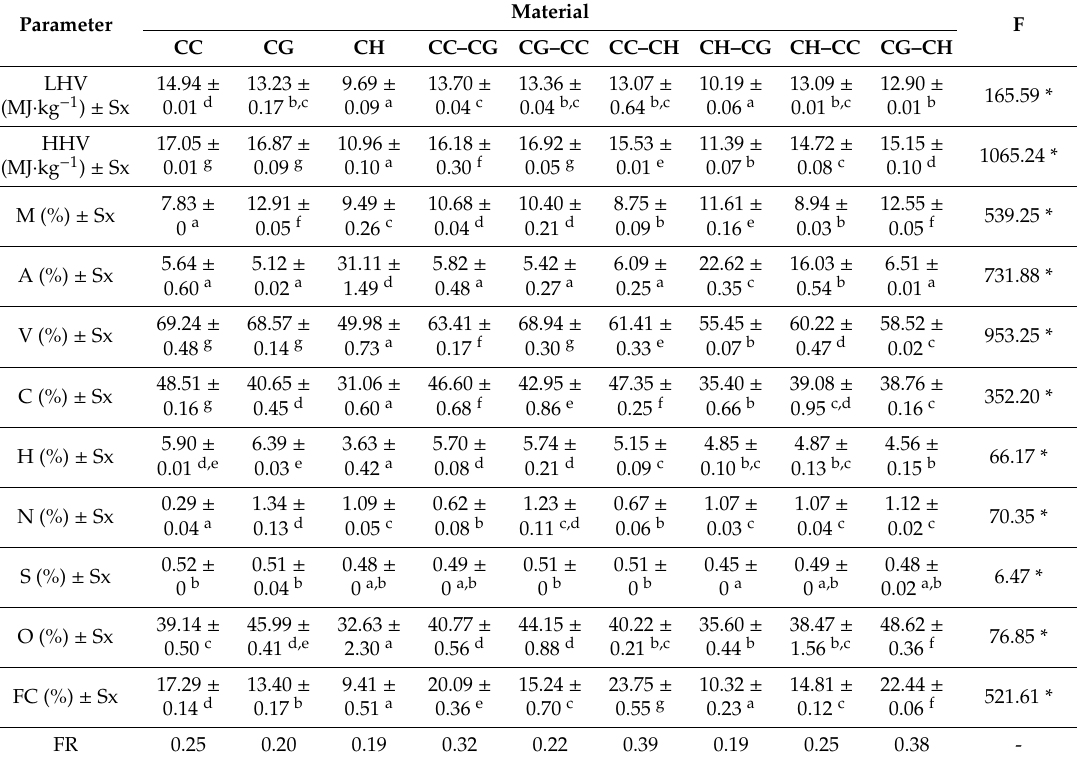
Table 2. Results of the technical and elemental analysis of the tested biomass (dry mass). Parameter